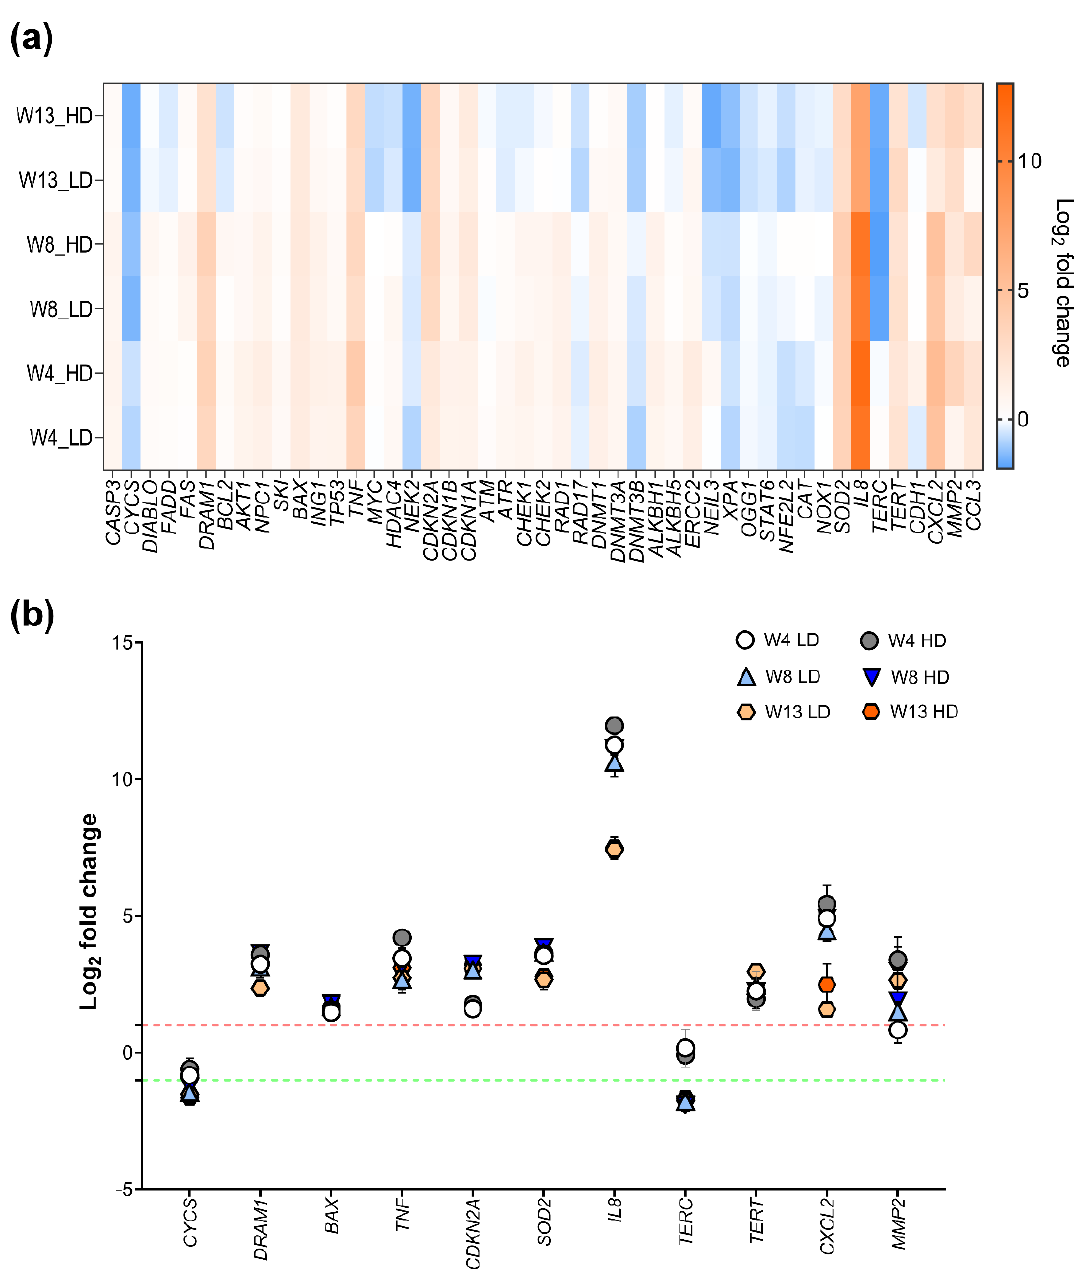
Figure 4. Regulation of gene expression in multiwalled carbon nanotubes (MWCNT)-exposed HBEC- 3KT cells. ( a ) Heatmap illustrates mean fold changes in expression at 4 (W4), 8 (W8), and 13 (W13) weeks of NM-401-exposure. ( b ) Regulated genes at 4, 8, and 13 weeks of exposure to the LD and HD of NM-401. Low dose (LD), high dose (HD). Data indicates mean ± SD ( n = 2). Dotted lines indicate log2 fold change 1 (red) and − 1